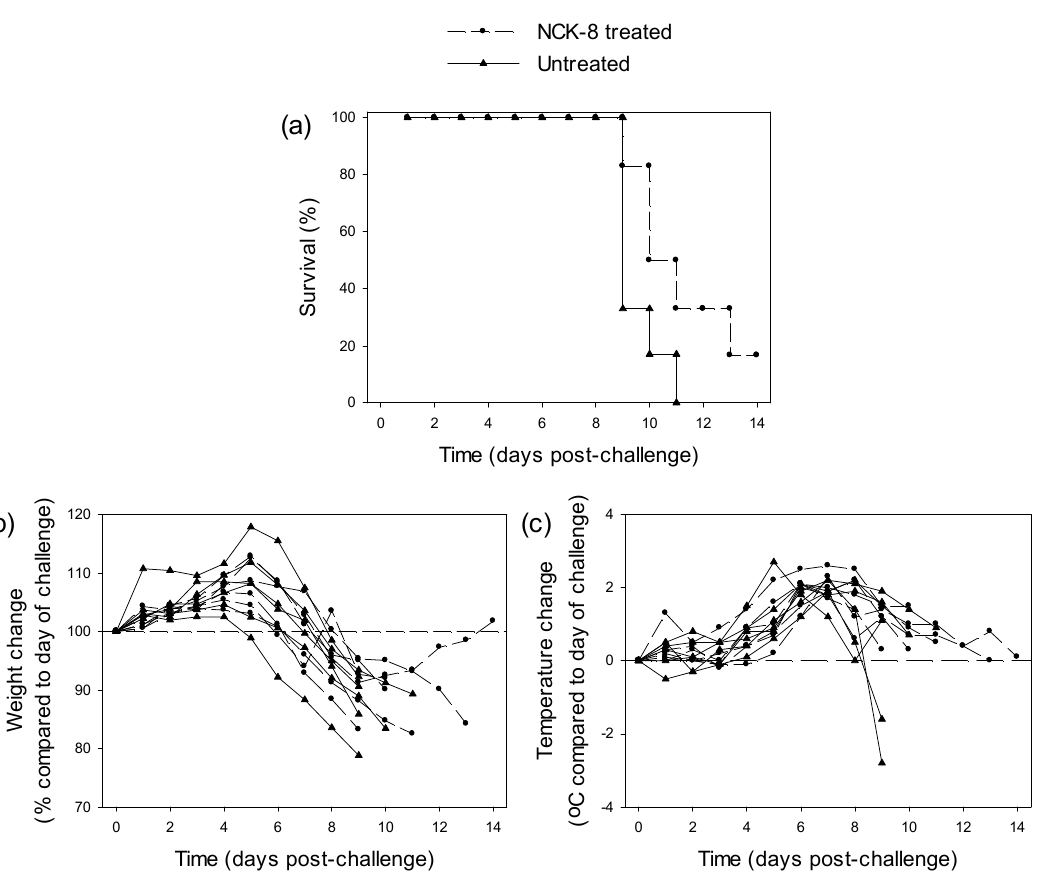
Figure 2. Survival and clinical parameters of guinea pigs treated with 5 mg/kg NCK-8 twice daily compared to untreated controls ( n = 6 per group). ( a ) Survival analysis after challenge with 10 3 TCID 50 EBOV; ( b ) Weight changes as a percentage compared to the day of challenge; ( c ) Temperature changes as °C difference compared to the day of challenge.